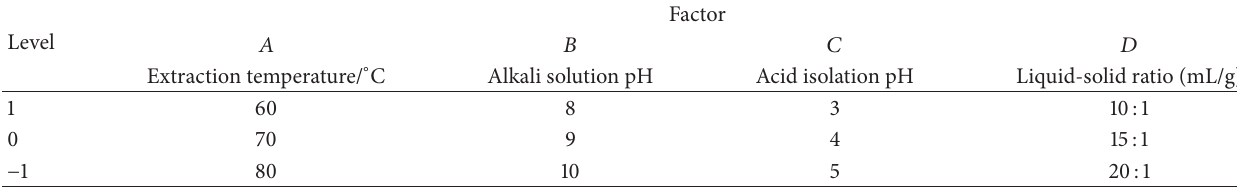
Table 1: Levels and factors of response surface analysis for extracting saponin from Camellia oleifera cake. Level